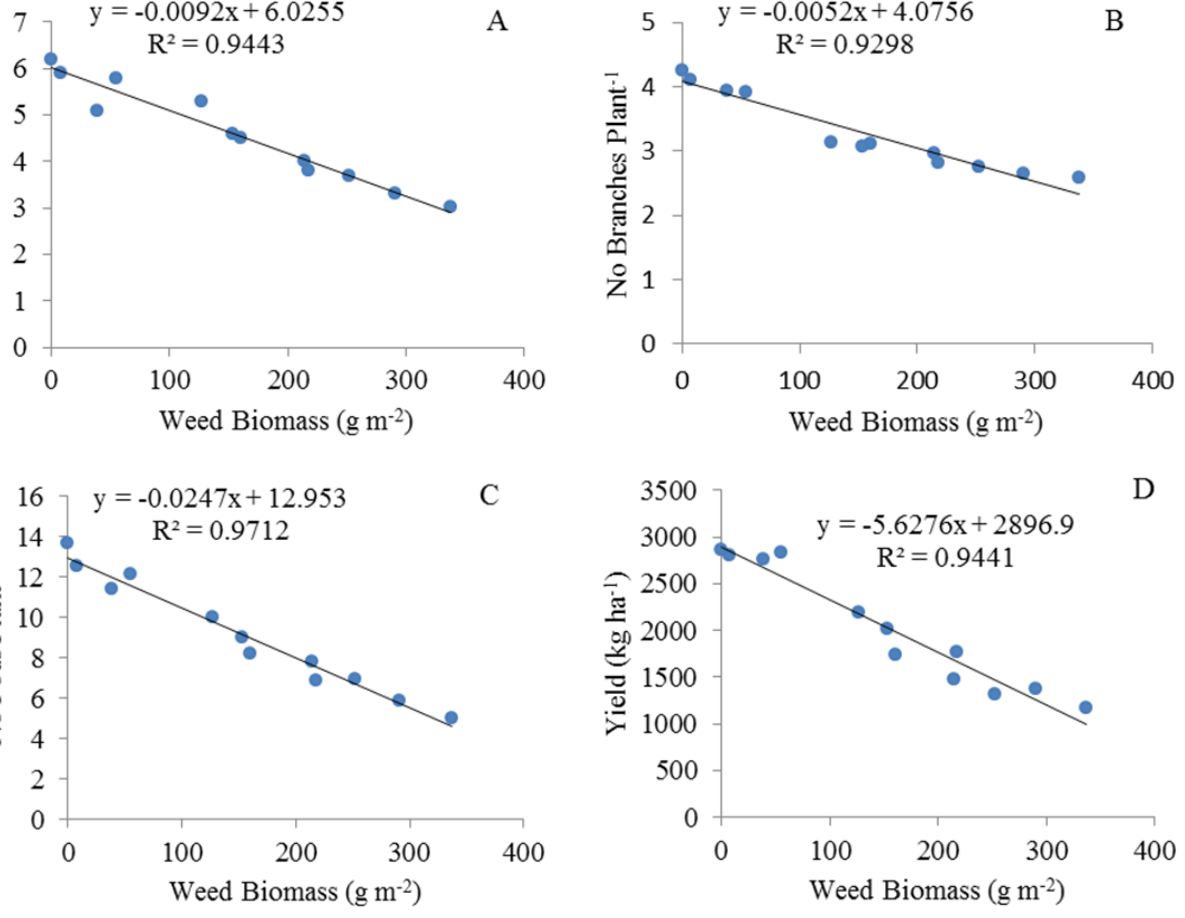
Fig. 3. Relationship between weed biomass and leaf area index (A), number of branches (B), number of pods (C), and yield (D) of dry